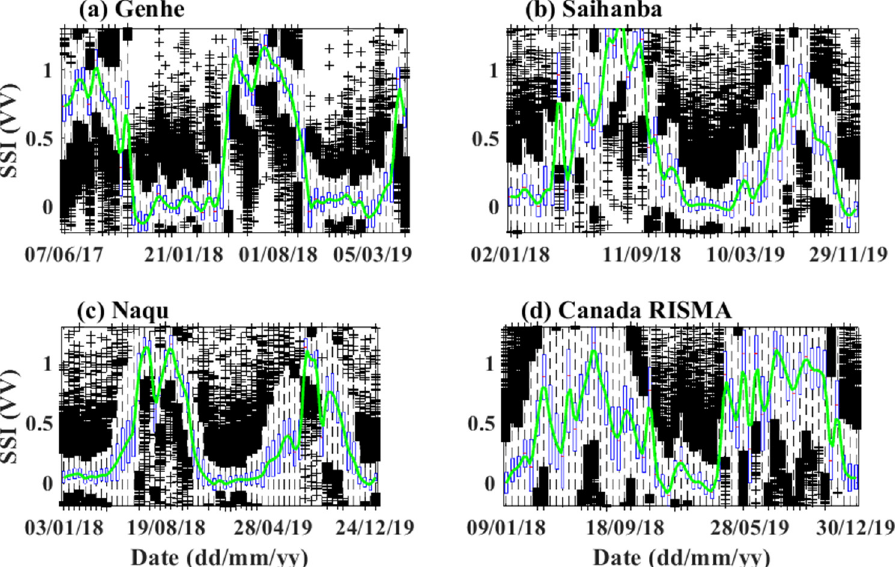
Figure 3. Same as in Figure 2 but the boxplot of SSI S1 at VV polarization.